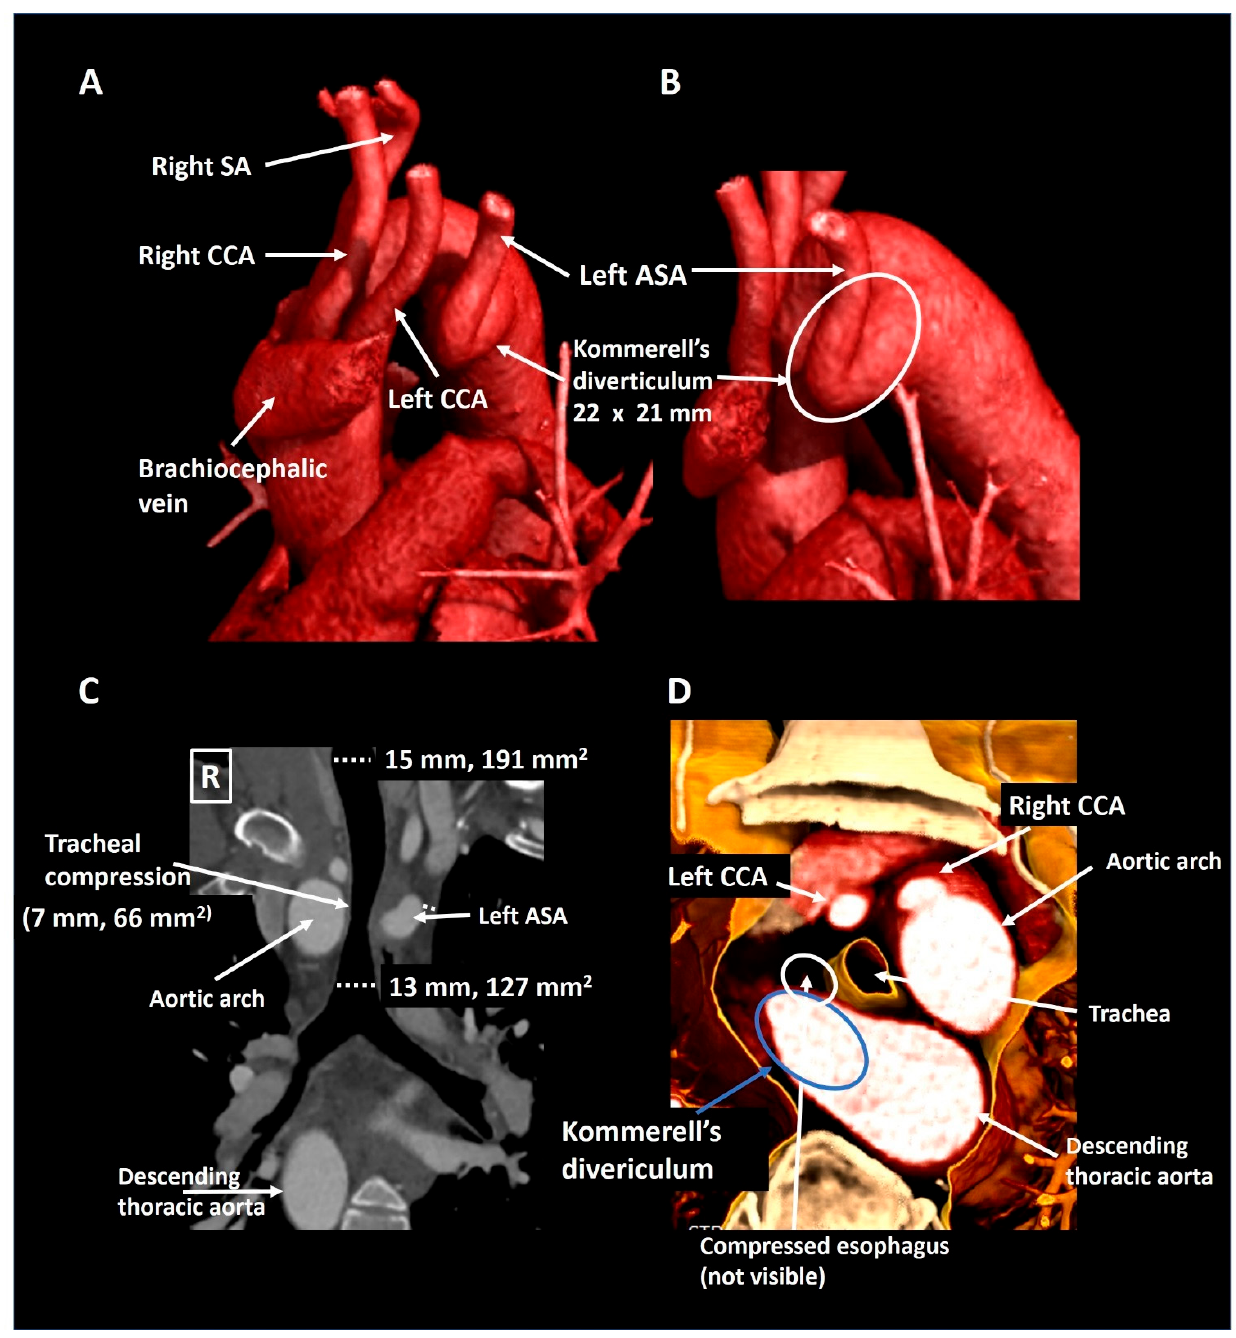
Figure 4. Patient 2. Panel ( A ) shows a lateral computed tomography reconstruction depicting a right-sided aortic arch with an aberrant left subclavian artery. The zoomed posterolateral reconstruction in panel ( B ) shows that the aberrant left subclavian artery is arising from a Kommerell’s diverticulum. Panel ( C ) is a coronal reconstruction that reveals tracheal compression. The axial 3D cross-section (panel ( D )) shows partial posterior compression of the trachea which was secondary to tracheal bowing and not directly to compression by the vascular structures. ASA, aberrant subclavian artery; CCA, common carotid artery; SA, subclavian